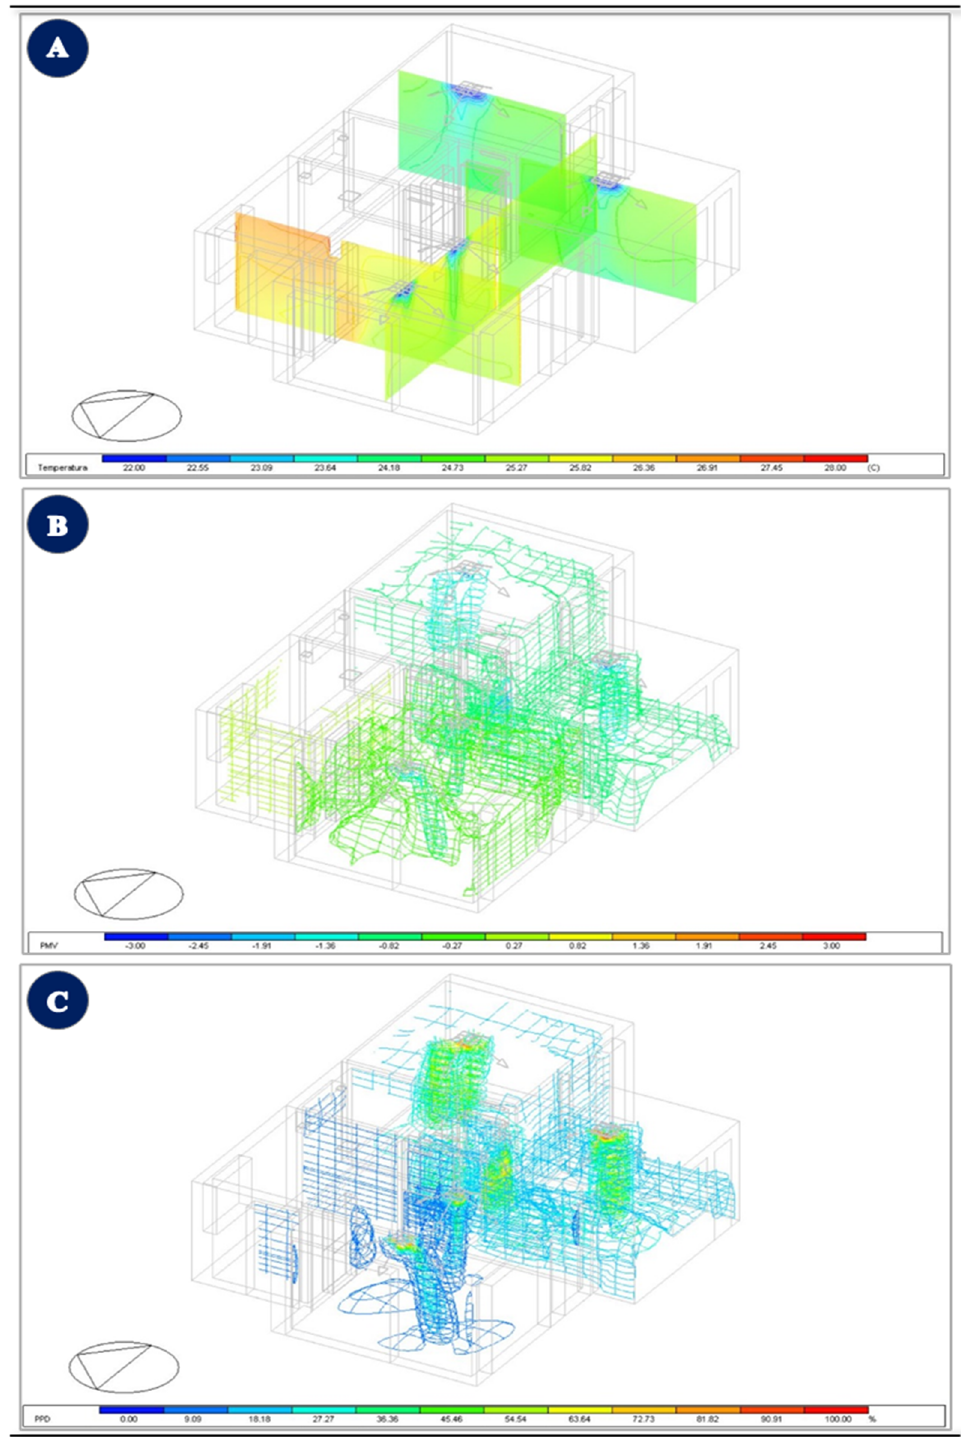
Figure 6. CFD results on 12 July at 10:00: ( A ) air temperature 2D distribution; ( B ) PMV and ( C ) PPD 3D distribution.